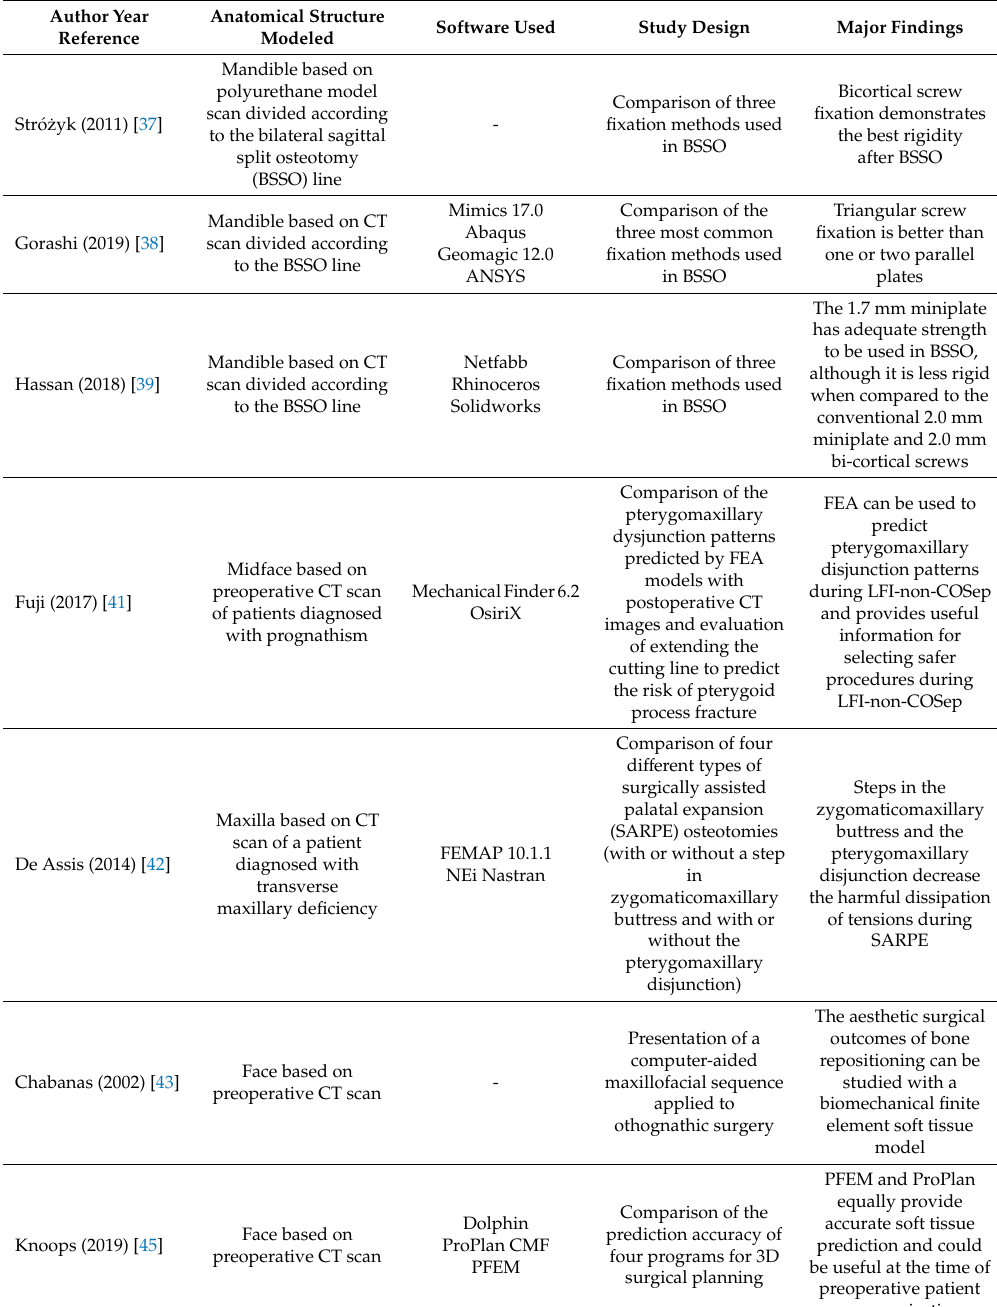
Table 2. Information regarding FEA conducted in the field of orthognathic